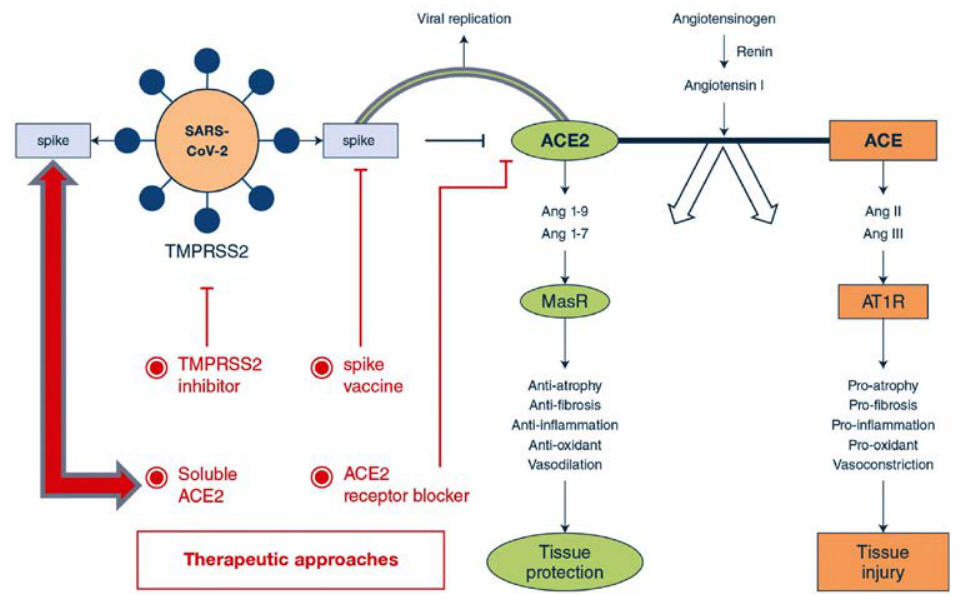
Fig. 2. Potential therapeutic targets to address ACE2-dependent SARS-CoV-2 infection. Both coronaviruses (SARS- CoV & SARS-CoV-2) use ACE2 for their transmission pathogenesis into the host cell. SARS-associate coronaviruses induce down-regulation of the ACE2 by selective binding of S-glycoprotein with ACE2 rather than ACE receptor. This causes viral transmission into host cell and its replication, as well as severe pulmonary infection. Therapeutics may comprise (i) S-glycoprotein-based vaccines; (ii) TMPRSS2 inhibitor to block the S-protein priming; (iii) ACE2 receptor blockage giving anti-ACE2 peptides or antibodies or (iv) slowdown viral entry by soluble form of ACE2, which competitively bind with SARS-CoV-2 and reduce viral spreading ultimately preventing pulmonary infection using exclusive enzyme function. Adapted from Zhang et al. 4 . Article distributed under creative common attribution (CC-BY)